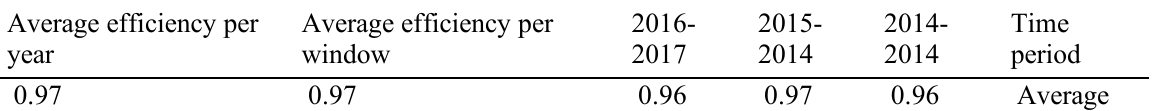
Table 5 . Results of efficiency assessment with window data envelopment analysis in Zabol